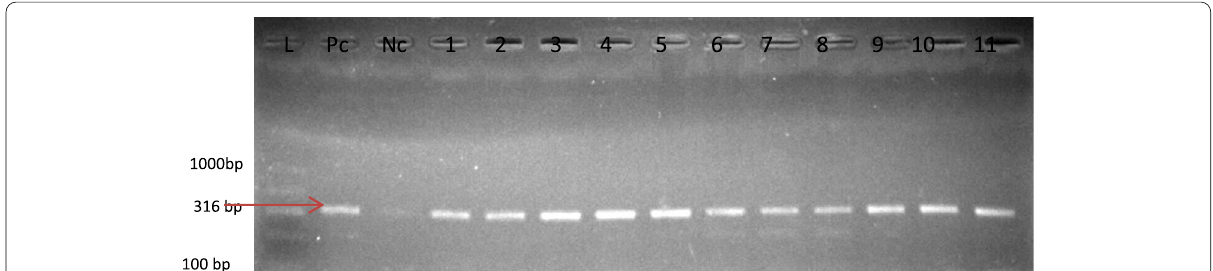
Fig. 7 Electrophoresis photomicrogram ace gene detected at 316 bp. L represents a molecular marker of 1.2 kb, Pc is a positive control DSM 19130 V.